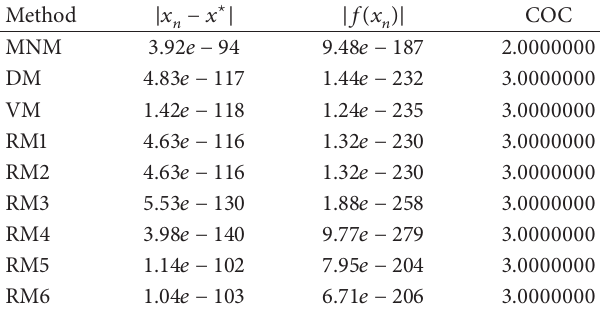
Table 1: Comparison of various iterative methods for the function (𝑥) under the same total number of function evaluations (TNFE) 𝑓 1 required by all methods.